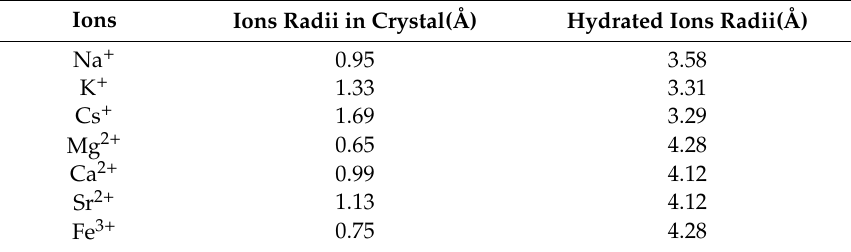
Table 1. Radii of ions in crystal and hydrated states